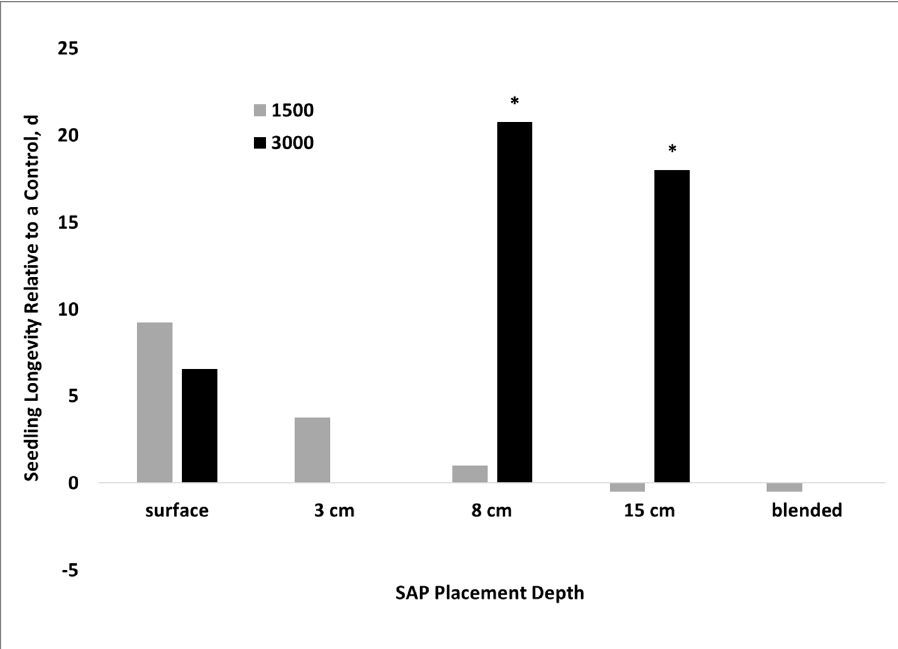
Figure 3. Seedling longevity, number of days alive, as a function of a superabsorbent polymer (SAP) rate and placement relative to an untreated control averaged across 108 d of a glasshouse study with bottlebrush squirreltail. The SAP (1500 or 3000 kg ha − 1 ) was blended with the soil to a depth of 15 cm or placed in a band at the surface or at 3, 8, or 15 cm deep directly below the seed. The soil was then saturated and allowed to dry down. Bars marked with “*” were significant at p = 0.05. As with longevity, the interaction SAP Rate*Placement Depth had a significant impact on seedling length (Table 2). Although differences were measured, there were no clear trends for shoot length. The 3000 kg SAP ha − 1 rate at 8 cm depth increased seedling length, while 1500 kg SAP ha − 1 decreased it (Table 4). Table 4. Bottlebrush squirreltail seedling length, relative to an untreated control, as a function of superabsorbent polymer (SAP) rate and placement for a glasshouse study. The SAP (1500 or 3000 kg ha − 1 ) was blended with the soil to a depth of 15 cm or placed in a band at the surface or at 3, 8, or 15 cm deep directly below the seed; the soil was saturated and allowed to dry down. Bolded lengths are significant.